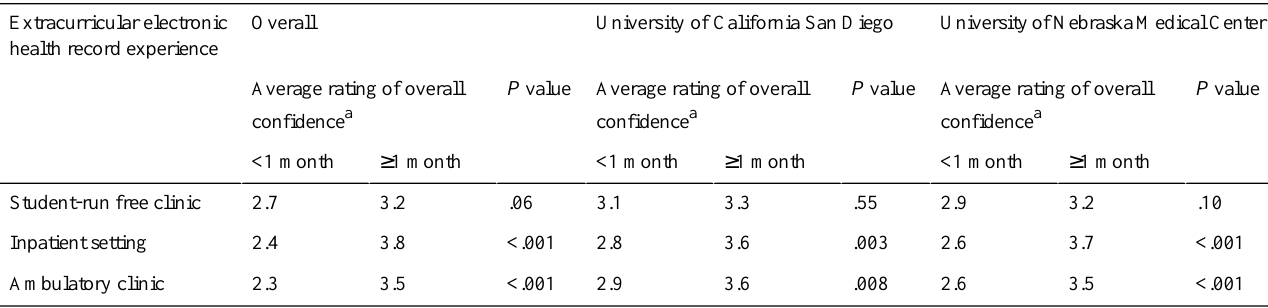
Table 2. Impact of extracurricular electronic health record experience on mean Likert scale score for overall